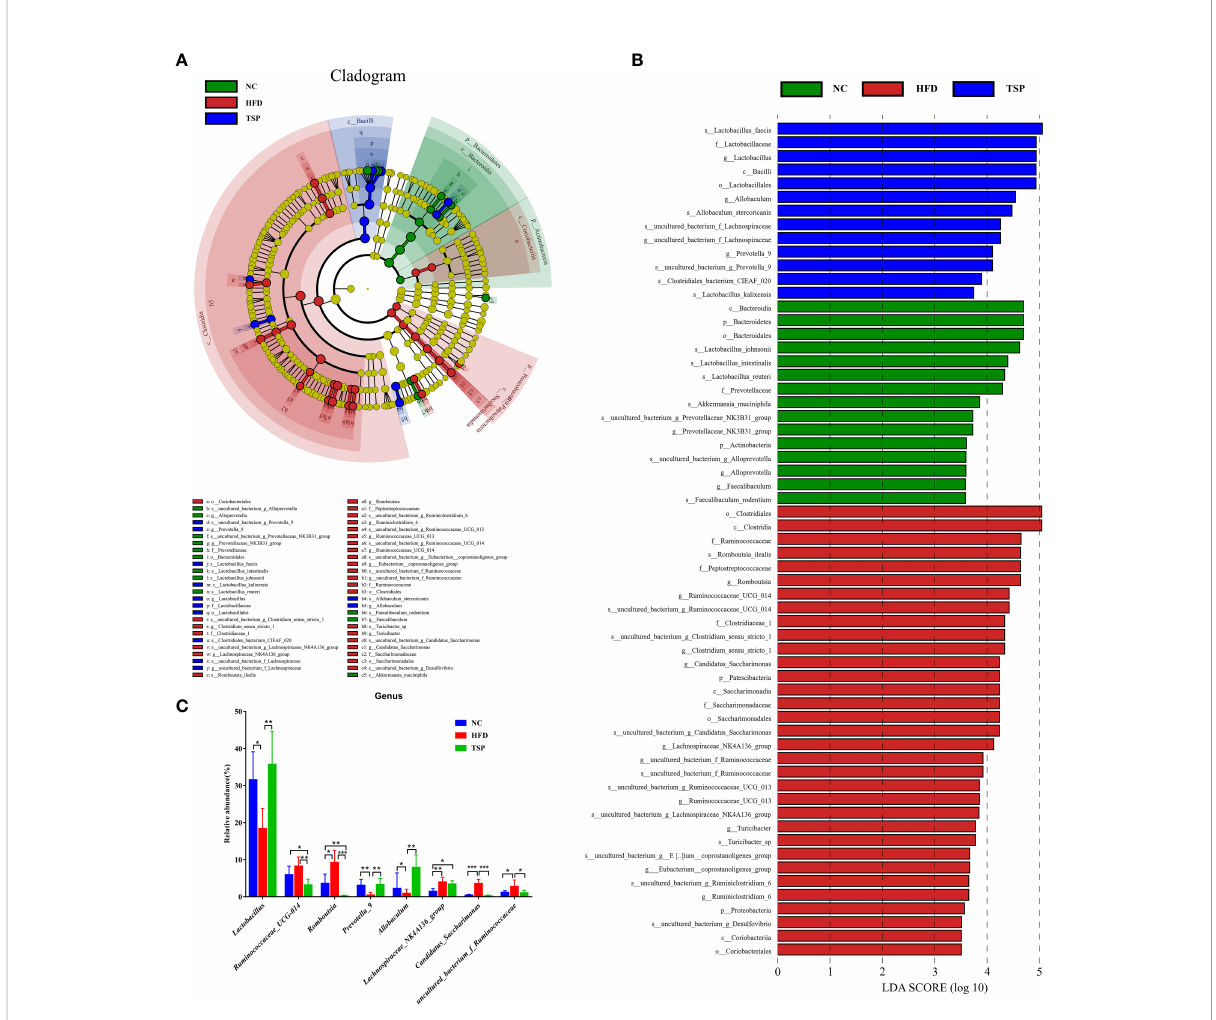
FIGURE 6 TSP supplementation induced gut microbial changes in mice. (A) Linear Discriminant Analysis Effect Size (LEfSe) analysis of key genera of gut microbiota in mice, (B) and the LDA score, (C) signi fi cantly changes ( p < 0.05) among top 15 taxa of the composition of the gut microbiota at genus taxa level, * p < 0.05, ** p < 0.01, and *** p <